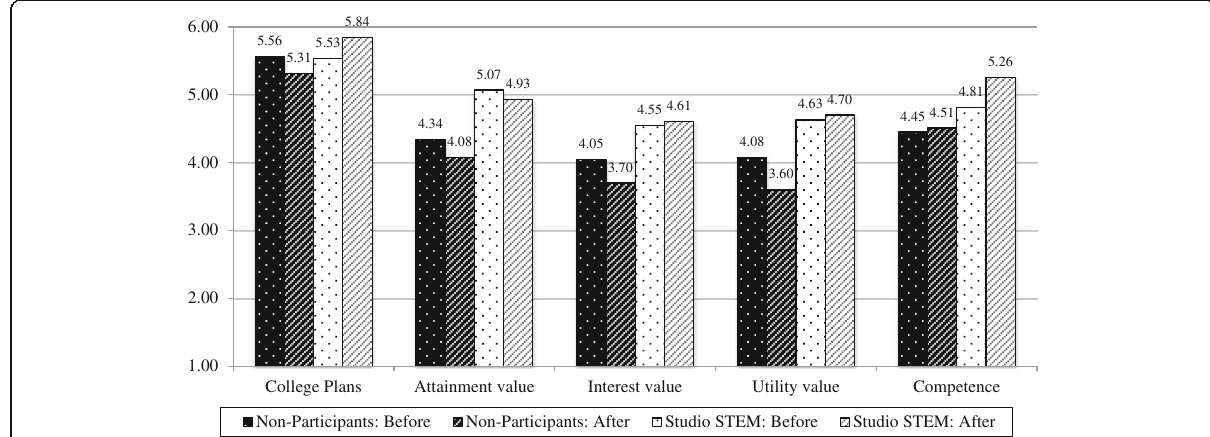
Fig. 1 Means comparison between Studio STEM participants and the non-participants before and after program participation. Studio STEM participants n = 19; non-participants n = 102